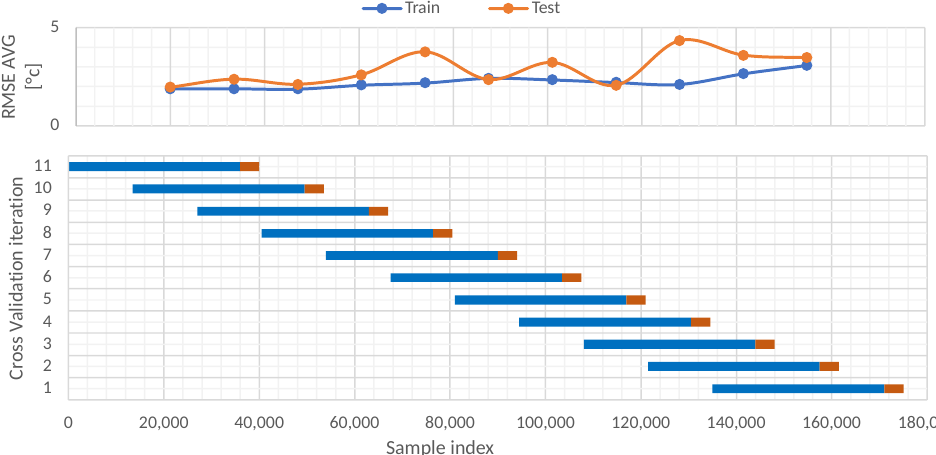
Figure 11. Blocking time series split cross-validation data